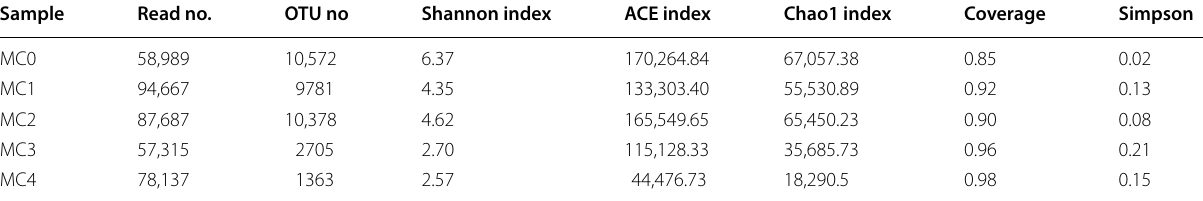
Table 1 OTU numbers and diversity index results of the microbial communities